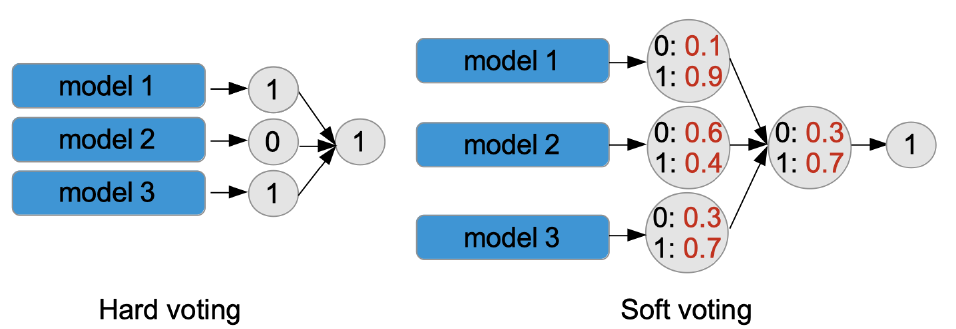
Figure 3. The figure shows with an example how both hard and soft voting work. The ensemble consists of three base models able to predict two possible classes, which are labeled with 0 and 1. Hard voting ( left side) predicts the class that obtained the most votes by base models. In the example, the voting policy outputs the class labeled 1, which is predicted by two out of three models. Soft voting ( right side) averages the class pseudo-probabilities of the base models (represented in red in the figure) so that the class with the highest average probability is